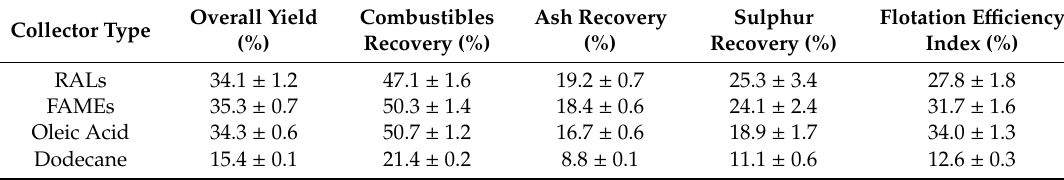
Table 1. Performance results from Site 1 batch flotation experiments using raw algal lipids (RALs) and fatty acid methyl esters (FAMEs) compared to oleic acid and dodecane controls at a fixed dosage of 2.79 kg / t and at pH